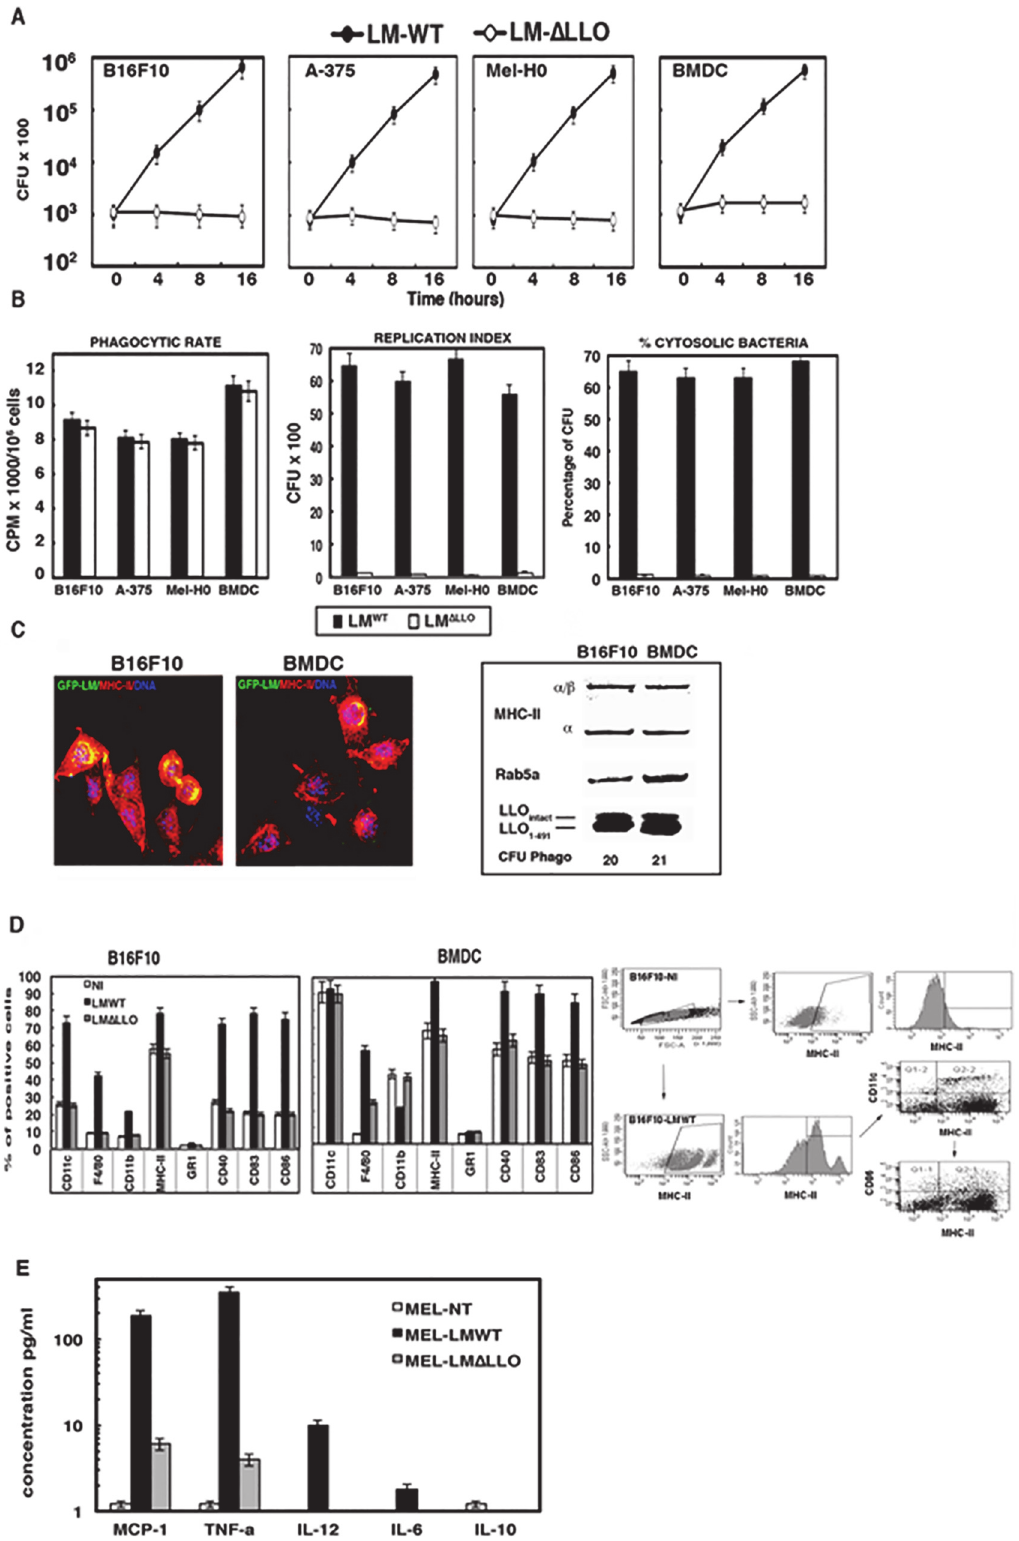
Fig 1. Listeria induced transformation of melanoma into dendritic cells. A , Kinetic analysis of BMDC, murine (B16F10) and human (A-375 and Mel-H0) melanoma cells infected with different LM strains (LM WT , LM Δ LLO ). Results are expressed as CFU (mean ± SD) obtained with triplicate samples from three